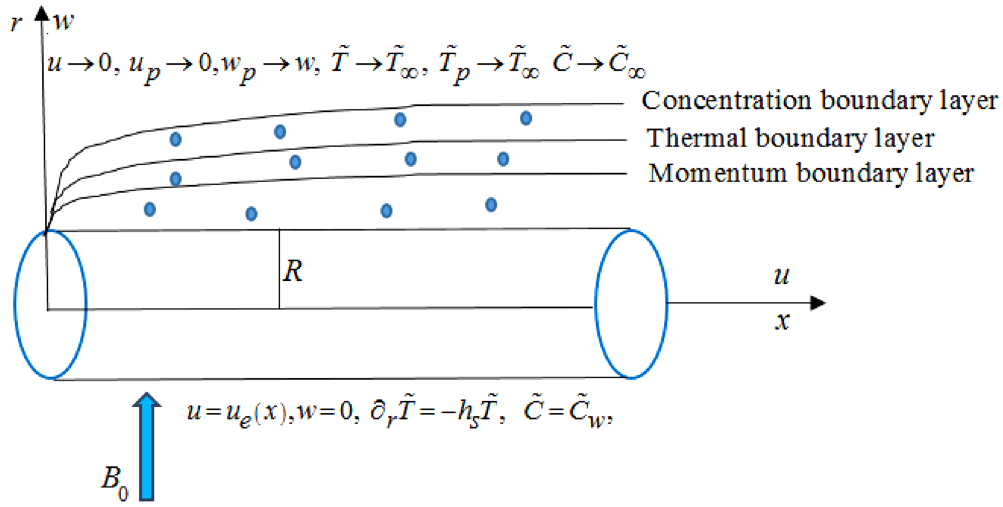
Figure 1. Flow configuration of the